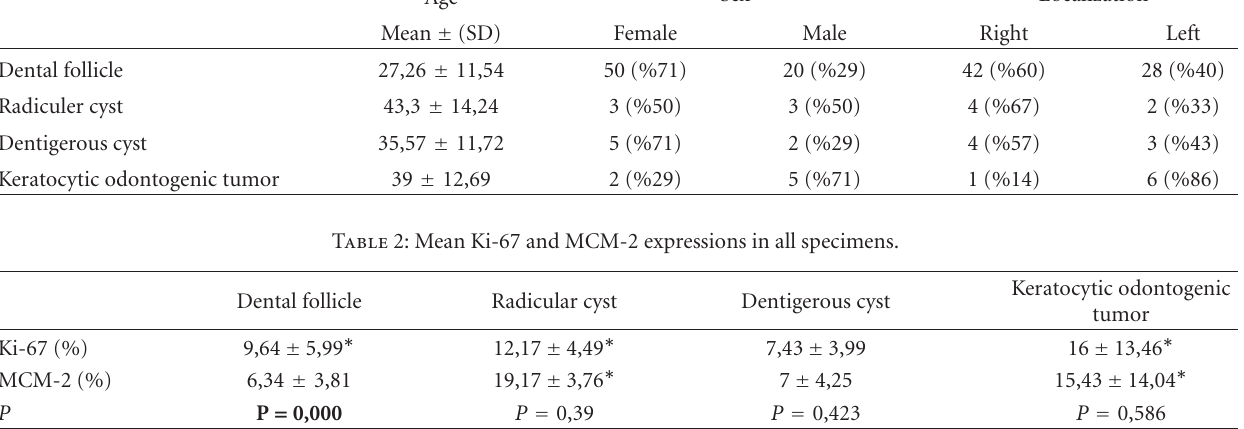
Table 1: The distribution of all specimens according to age, sex and localization of lesions. Age Sex Localization Mean ± (SD) Female Male Right